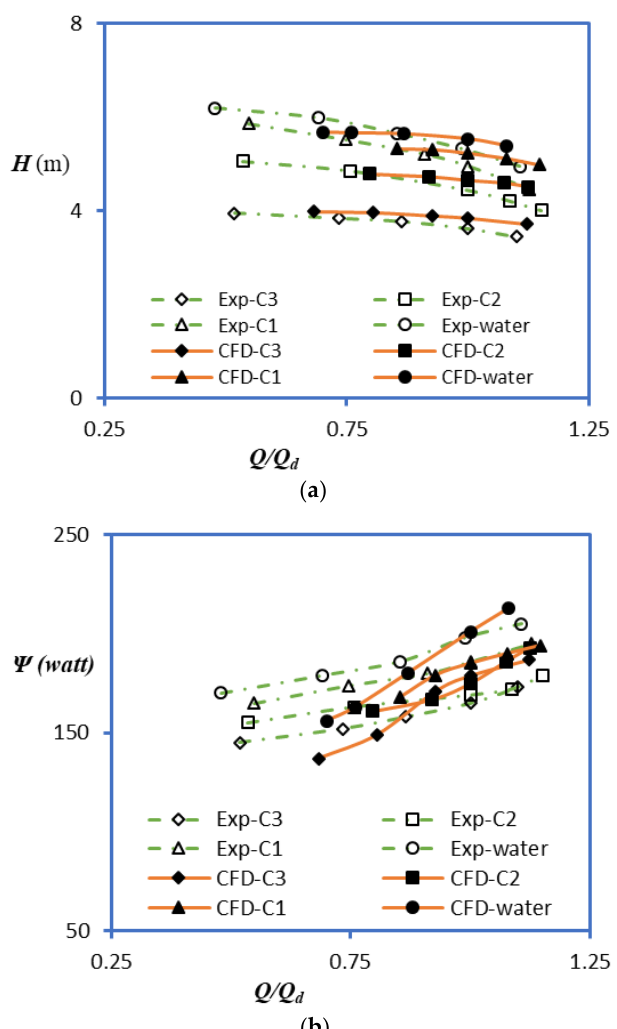
Figure 10. Validation of numerical results for all cases: ( a ) H versus Q/Qd and ( b ) Ψ versus